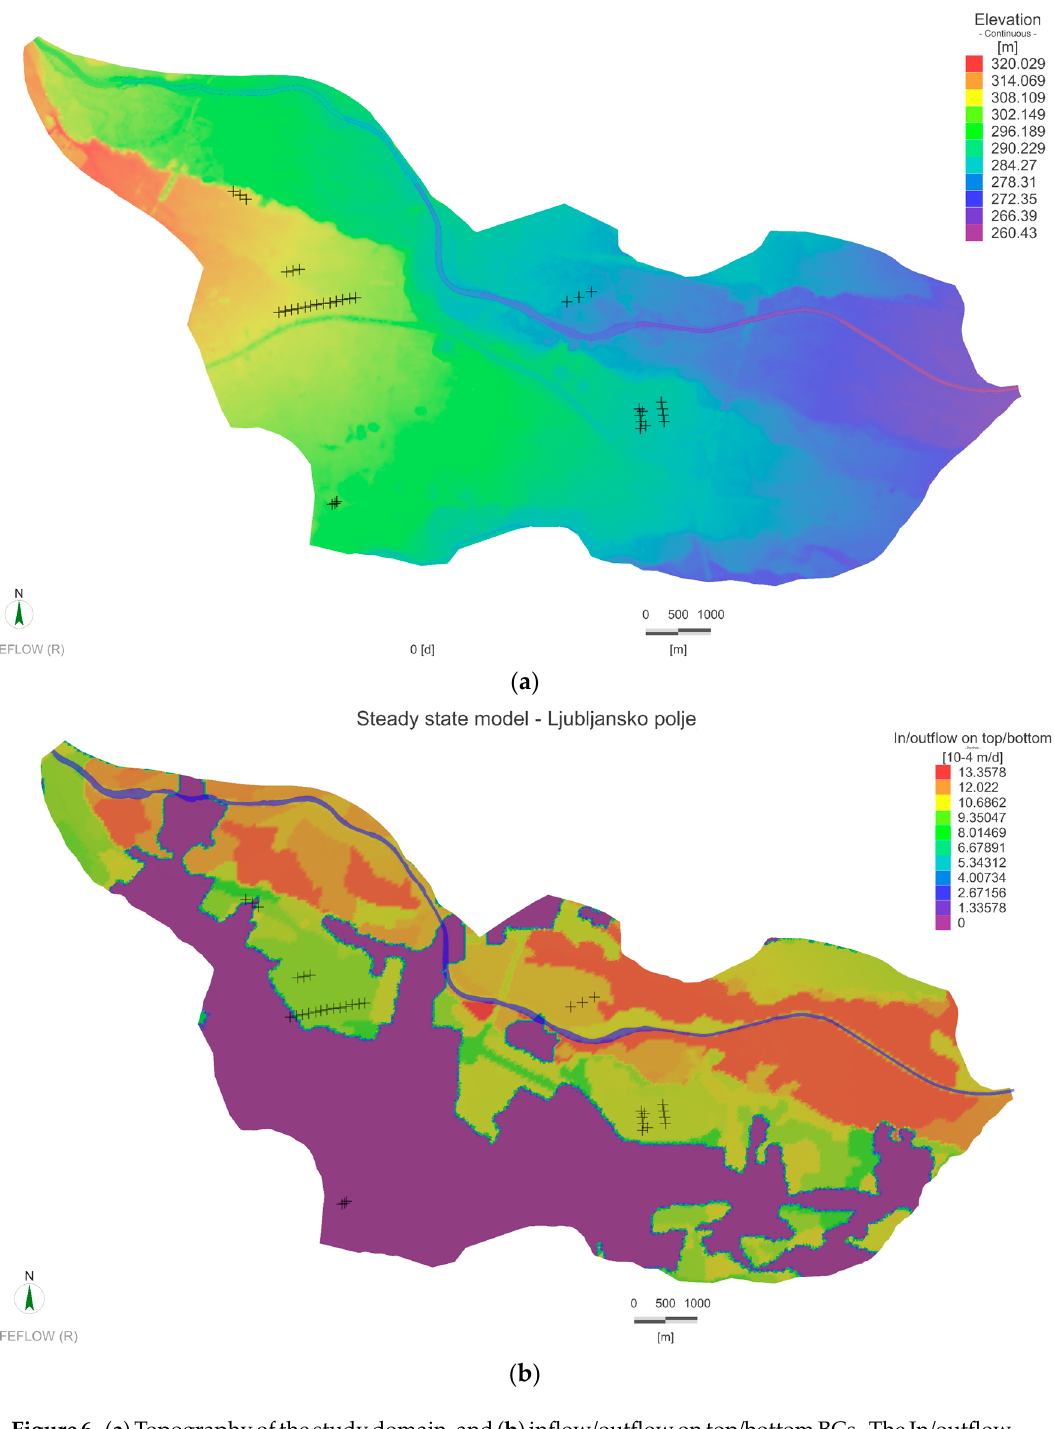
Figure 6. ( a ) Topography of the study domain, and ( b ) inflow/outflow on top/bottom BCs. The In/outflow on top/bottom BCs represents the mean percolation for the period 2010–2011 or the steady-state GW flow model. Black crosses show locations of the multilayer well BC.